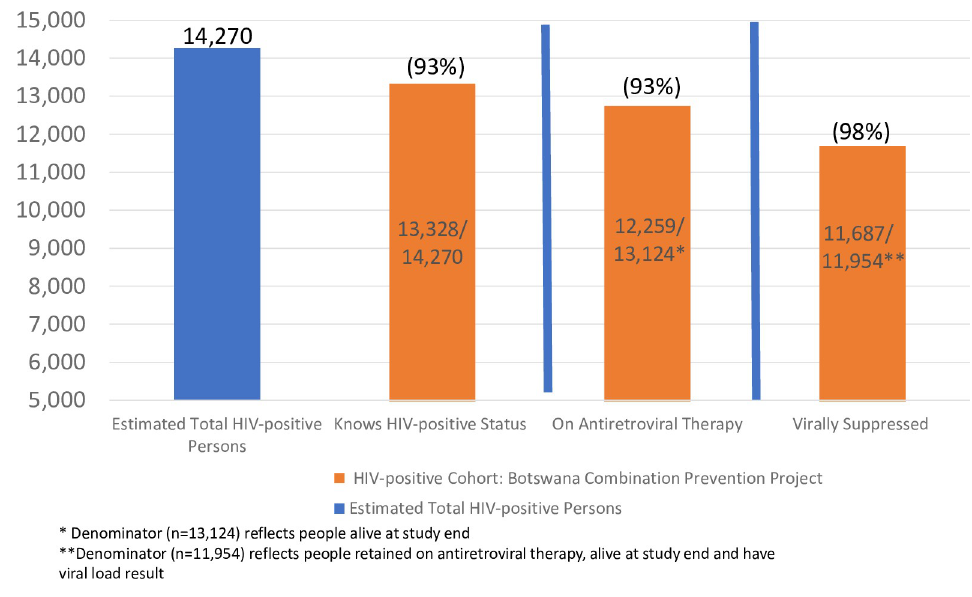
Fig 1. HIV care cascade among HIV-infected adults in 15 intervention communities.